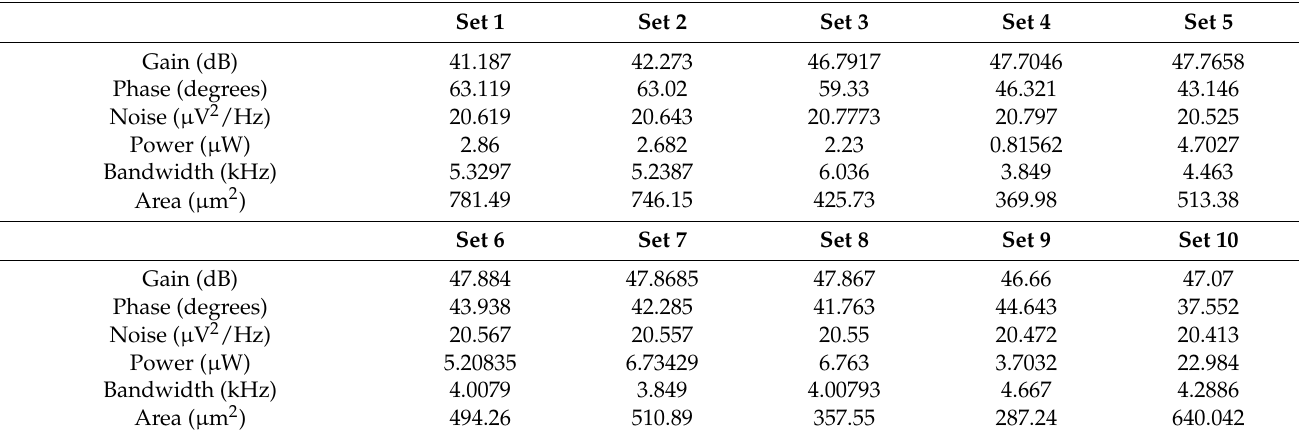
Table 7. Cadence simulation results for designs resulting from the use of the ANN-assisted goal attainment